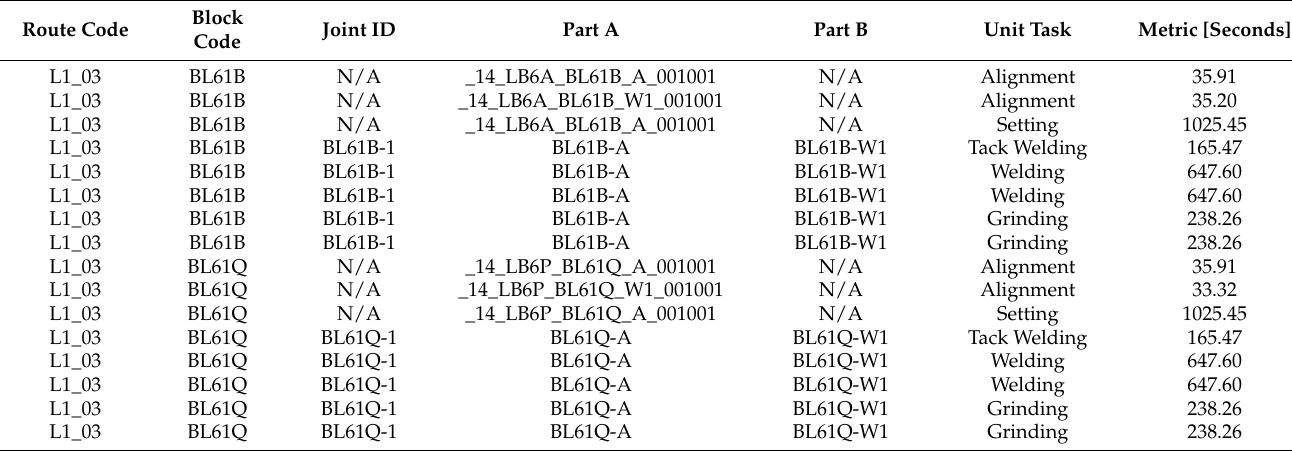
Table 5. Results of metric calculation for detailed activities (excerpt).